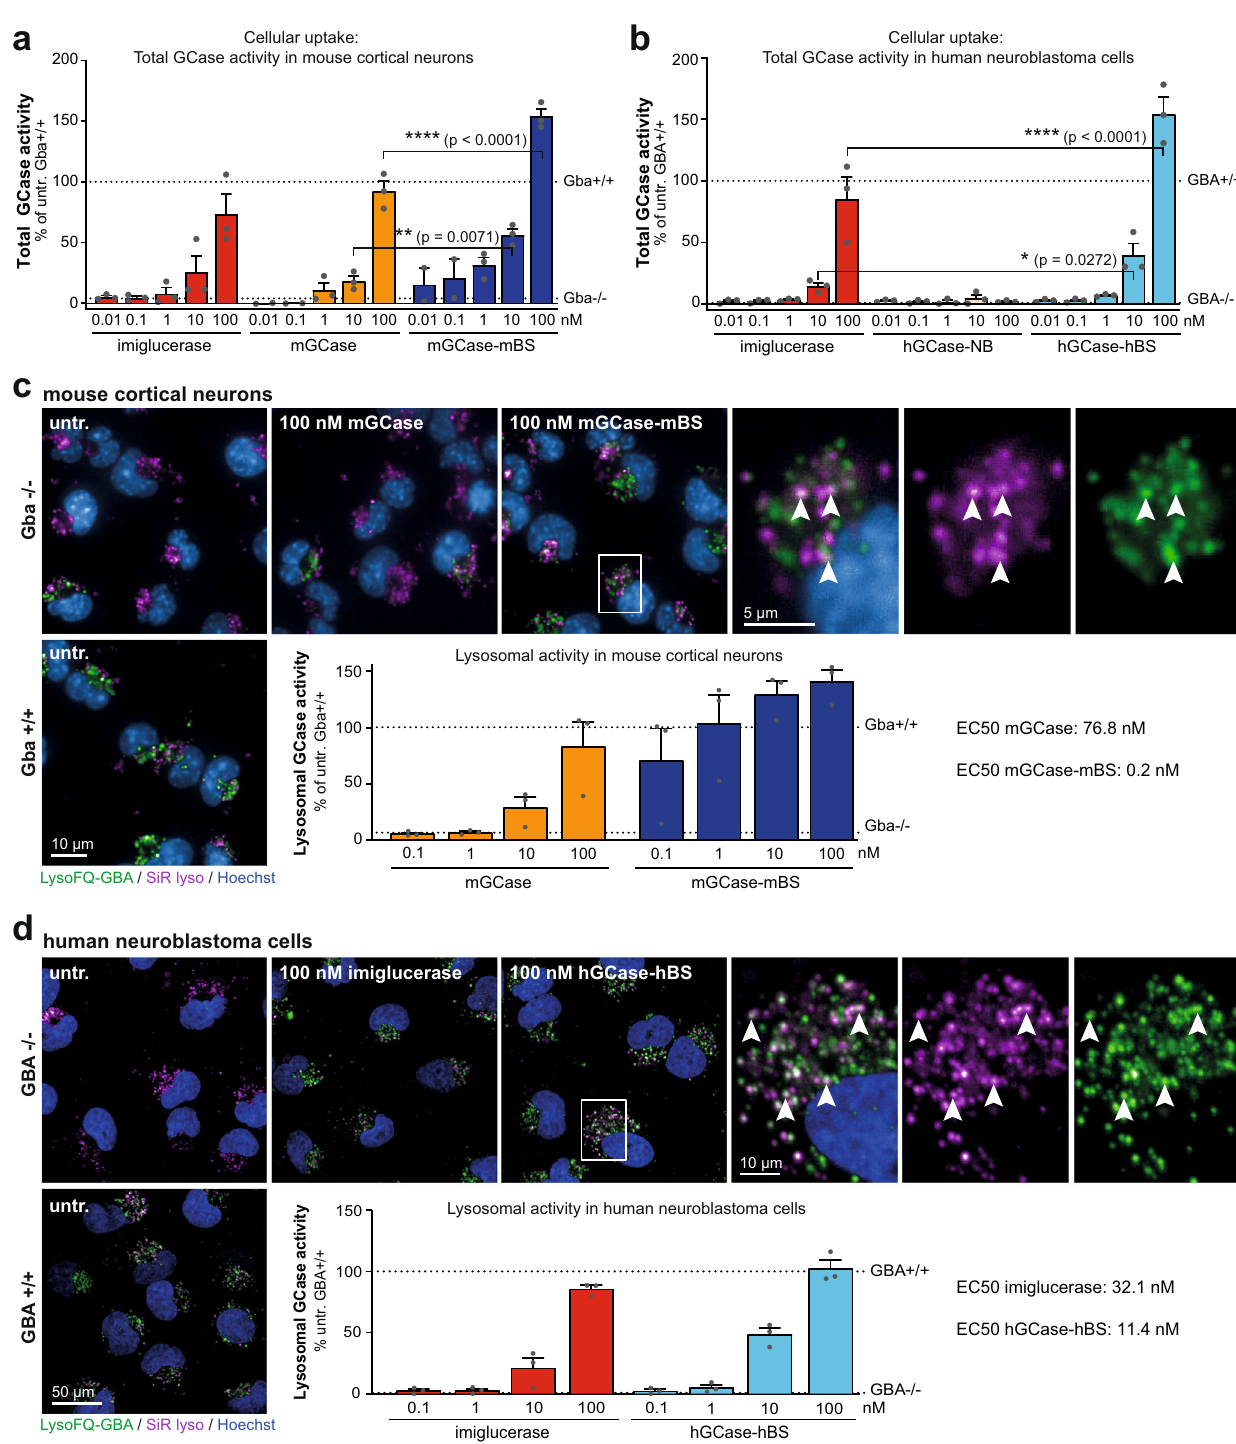
Fig. 2 | The Brain Shuttle module improves cellular uptake and lysosomal activity in vitro. a Total GCase activity in mouse cortical neurons as a measure of cellular uptake after 2h of treatment with imiglucerase, mGCase or mGCase-mBS. Datawasnormalisedto Gba +/ + cells. n =3(formGCaseandmGCase-mBS,thetwo lowestconcentrationshaveonlybeenrepeatedtwice). b TotalGCaseactivityinH4 cells as a measure of cellular uptake after 2h of treatment with imiglucerase, hGCase-hBS-NB orhGCase-hBS. Data was normalisedto GBA +/+cells. n =3. c Live imaging of GCase activity (LysoFQ-GBA) and lysosomes (SiR lyso) and quanti fi ca- tion of colocalising signal in mouse cortical neurons. Data was normalised to